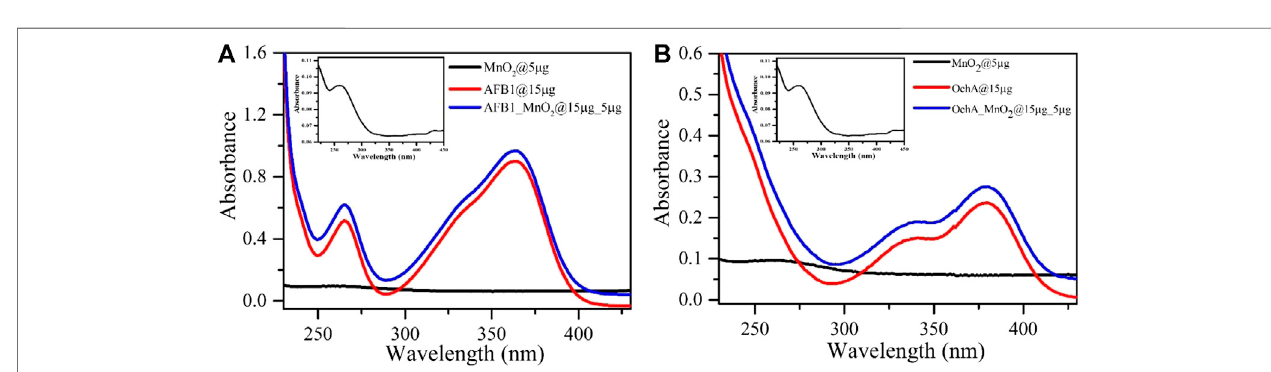
FIGURE5|(A) UV-visible absorption plotofMnO 2 nps(zoomedimageinboth insets),AFB1,andAFB1inthepresenceofMnO 2 nps. (B) UV-visible absorption plot of OchA and OchA in the presence of MnO 2 nps.